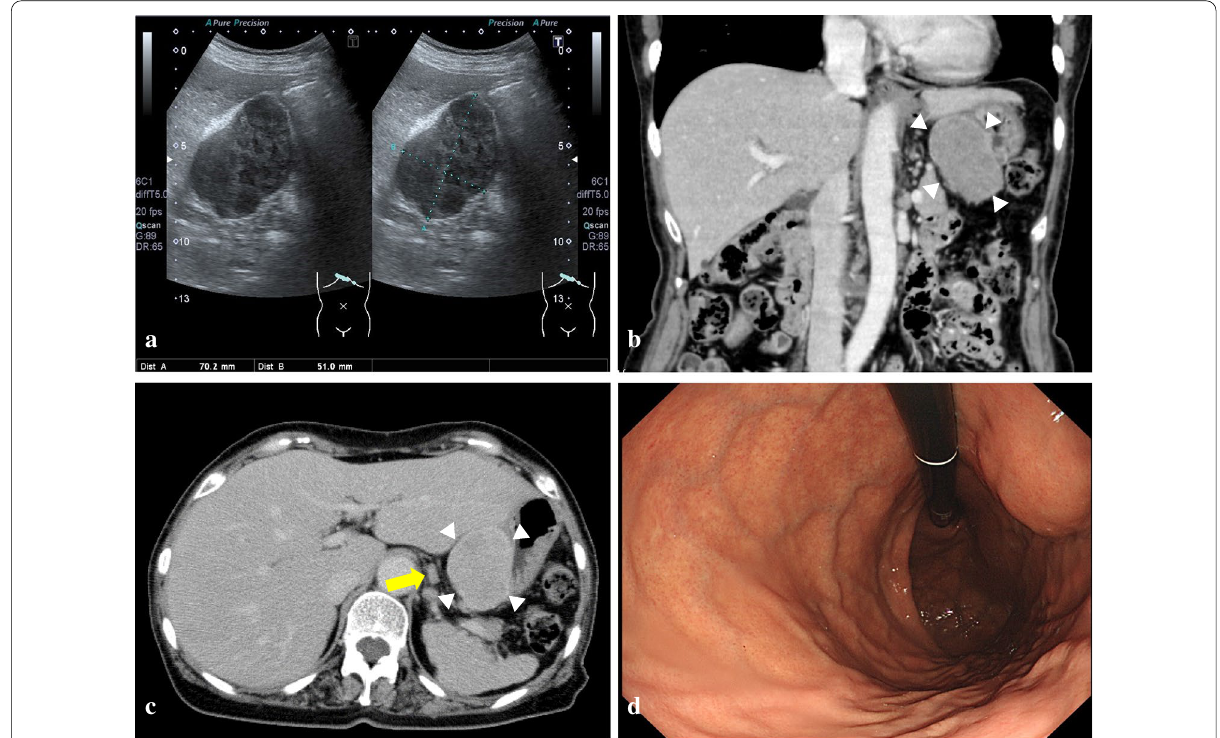
Fig. 1 a Abdominal ultrasonography revealing a well‑circumscribed hypoechoic mass, contiguous with the proper muscle layer, approximately 70 mm in size, located at the middle stomach on the lesser curve. b , c Contrast‑enhanced CT of the abdomen showing an extraluminal tumor with heterogeneous enhancement at the middle stomach on the lesser curve (white arrowheads), accompanied with one swollen lymph node approximately 10 mm in size (yellow arrow) and several small lymph nodes in the perigastric region. d Endoscopy showing compression of the anterior wall of the gastric body along with normal